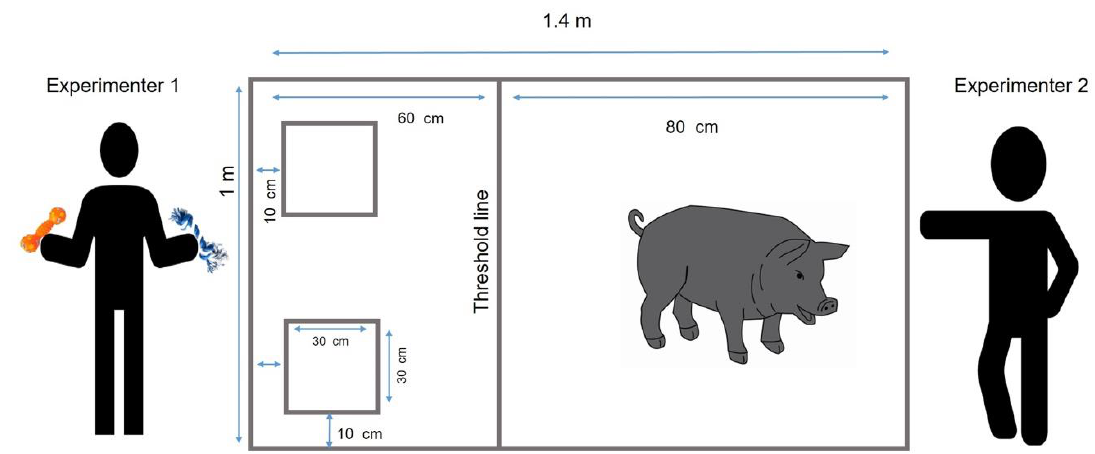
Figure 1. Object discrimination was evaluated into a rectangle drawn on the floor. Objects were placed into the 30 cm squares. Object selection occurred when piglets held an object and crossed the threshold line walking toward experimenter 2.